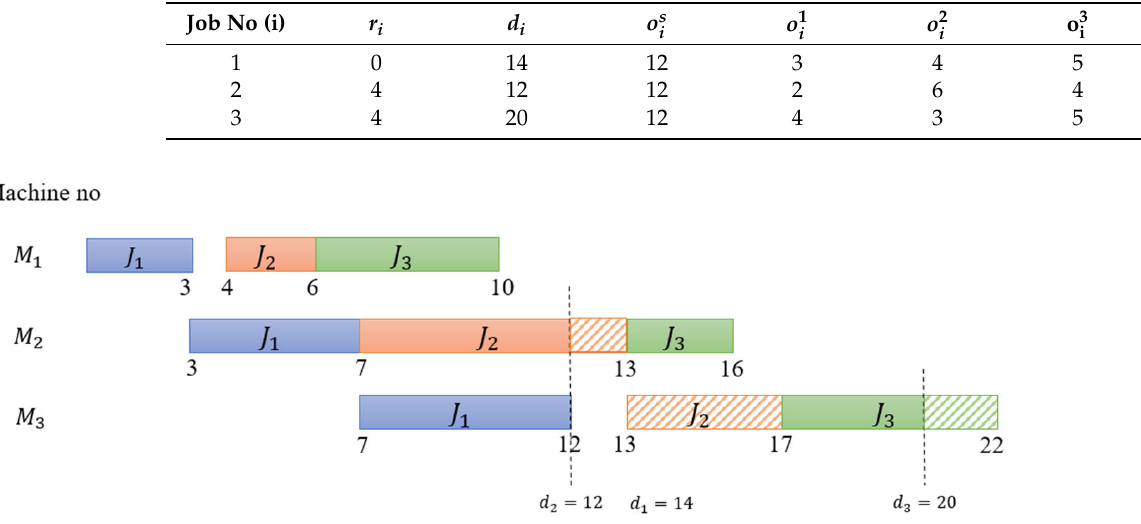
Table 1. An example of a PFSP problem with the late work objective function.